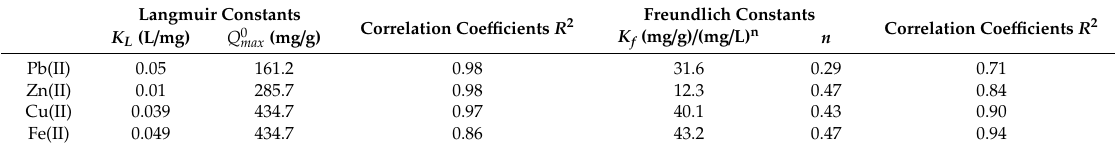
Table 2. Langmuir and Freundlich constants for the adsorption of Pb(II), Zn(II), Cu(II), and Fe(II) onto RC-MWS.